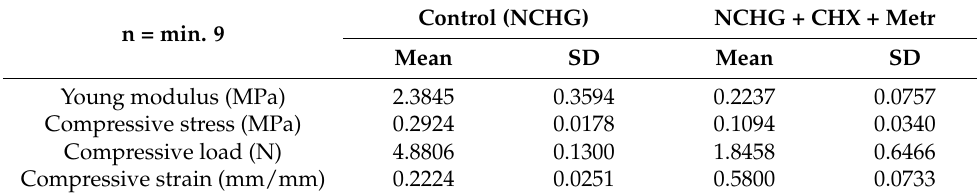
Table 1. Mechanical properties of NCHGs. n = min. 9